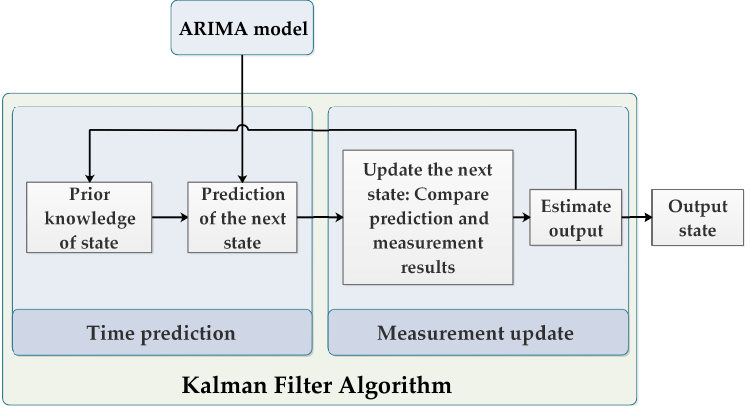
Figure 2. Kalman filter